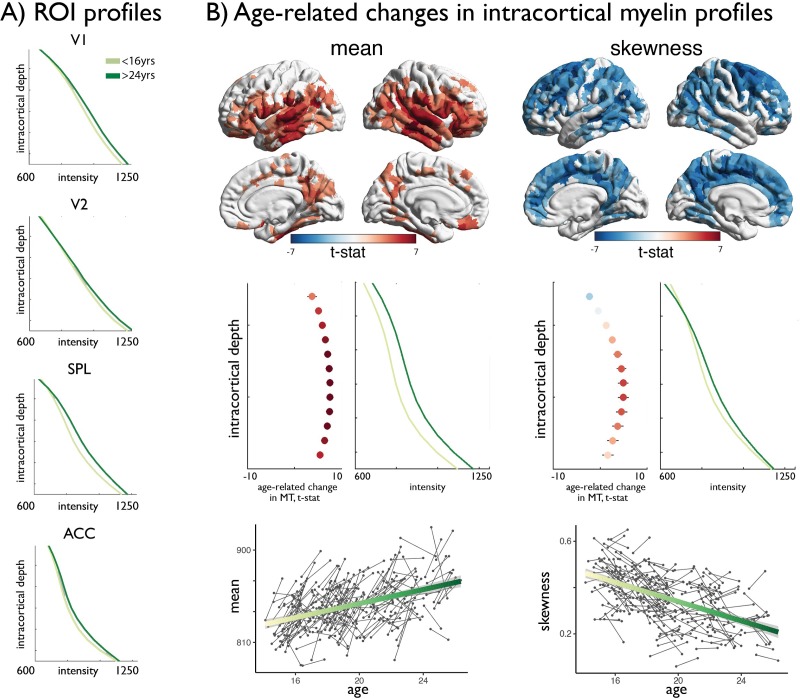
Age-related changes in MT moments.(A) Shifts in MT profiles and moments from lowest to highest age strata shown for exemplar regions of laminar differentiation (Figure 1). (B) Upper. Age-related changes in MT moments (qFDR <0.00625). Middle. t-statistic (mean ± SD) of age-related changes in MT intensity at each intracortical surface across significant regions. Mean increases were balanced across surfaces, whereas decreases in skewness were driven by preferential intensity increases at mid-to-deeper surfaces. Lower. Individual changes across significant regions, with regression lines depicting age-related changes across the investigated range.